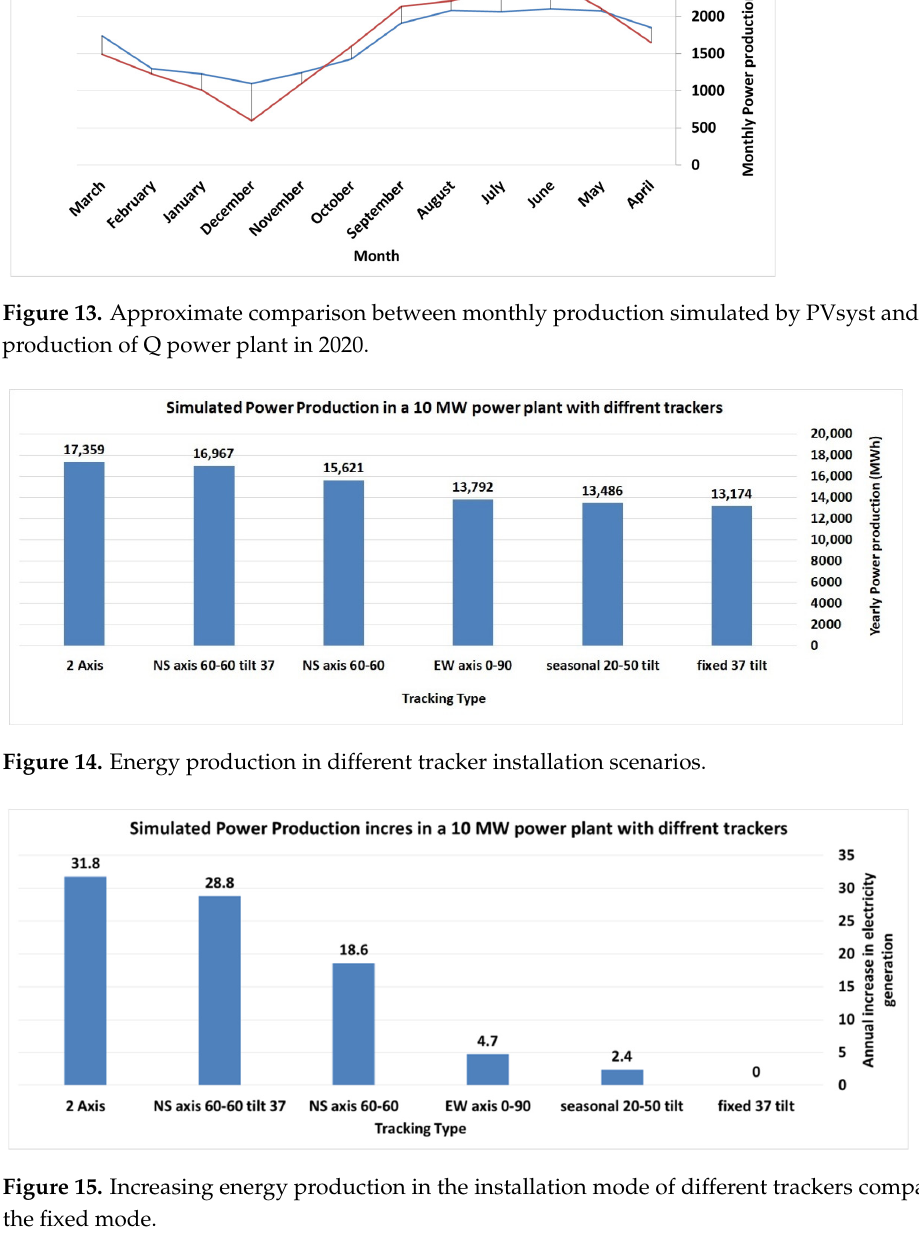
Figure 16. Monthly performance of hypothetical 10 MW power plant in Qom under the different tracking scenarios.